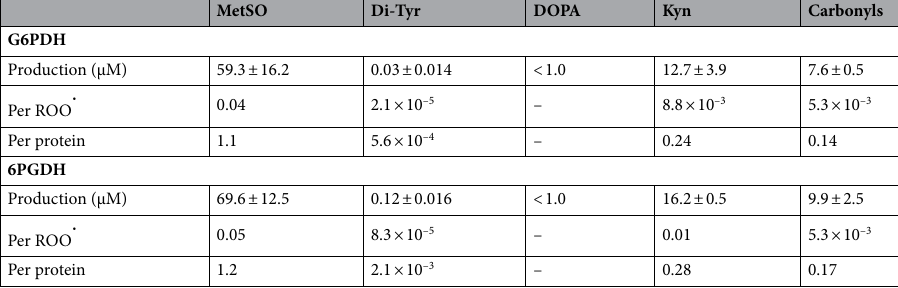
was observed, with a ‘smear’ of species detected at a wide range of higher and lower molecular masses, as well as at the positions of the monomer and dimer bands of G6PDH and 6PGDH (Fig. 5C, Fig. S3C). Mapping of amino acid oxidation sites and protein crosslinks by LC–MS. was determined by a peptide mass mapping (proteomic) approach, after digestion with LysC and trypsin 21 , with analysis performed using MaxQuant. The extents of modification at particular sites (modification occupancy) were calculated by dividing the signal intensities (area-under-the-curve) of all peptide spectral matches containing the modified position by the sum of the intensity of all peptides containing the residue under examination (i.e. both non-modified and modified). The sequence coverage obtained for control samples of G6PDH and 6PGDH was 92.5 and 99.8%, respectively, while those for the samples incubated with 10 and 100 mM AAPH were 92.5 and 92.1, and 99.8 and 98.7%, for G6PDH and 6PGDH, respectively (Fig. S4). For G6PDH, all Tyr (14) and His (6) residues were covered, whilst for Trp and Met, 11 (of 12) residues were detected. For 6PGDH all Tyr (25), His (2) and Trp (4) residues were covered, and 6 (of 7) Met residues. As presented in Figs. S5 and S6, a significant number of modified peptides were detected from the oxidized samples by LC–MS. Of particular note, is the observation that none of the Tyr, Trp or Met residues in the C-terminal regions of G6PDH and 6PGDH, were detected as modified species even with 100 mM AAPH after 180 min (Fig. S4). Incubation of G6PDH with AAPH resulted in an extensive modification of Trp and Met residues as detected by LC–MS (Fig. 6A). Modification levels of 19.4% and 36.4% of the Trp residues, and 14.4% and 38.2% of Met residues, were determined after incubation with 10 and 100 mM AAPH, respectively. For Tyr and His, lower levels of modifications were detected with 1.3% and 0.2%, respectively, after incubation of G6PDH with 100 mM AAPH. Similarly, incubation of 6PGDH with 10 or 100 mM AAPH led to a significant modification of Trp and Met (Fig. 6B), with levels of 29.2% and 53.7% for Trp determined after incubation with 10 and 100 mM AAPH, respectively, and 13.7% and 67.9% for Met under the same conditions, respectively.